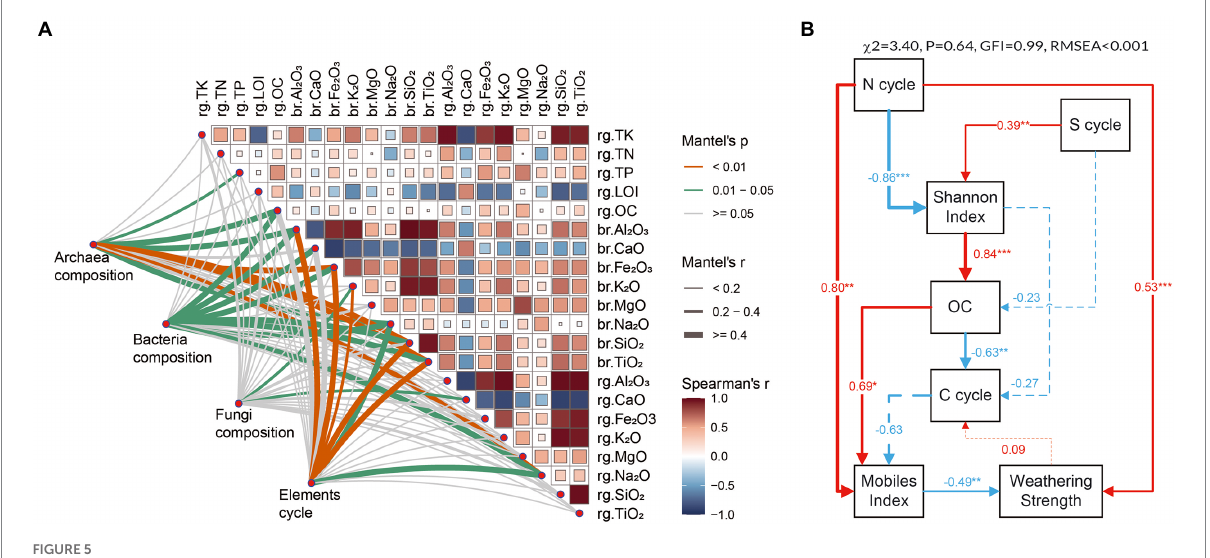
FIGURE 5 Biotic and abiotic drivers of microbial community composition and rock weathering. (A) Pairwise comparisons of environmental factors are shown, with a color gradient denoting spearman’s correlation coefficints. Taxonomic and functional (based on biochemical KEGG Orthologs) genes composition was related to each environmental factor of Mantel tests. Edge width corresponds to the Mantel’s r statistic for the corresponding distance correlations, and edge color denotes the statistical based on 9,999 permutations. (B) Structural equation modeling. The rg prefix indicates regolith and the br prefix indicates parent rock. Red and blue arrows represent positive and negative path coefficients, respectively, and dashed arrows represent non-significant paths ( p > 0.05). The path width is proportional to the absolute value of the path coefficients, and numbers are normalized path